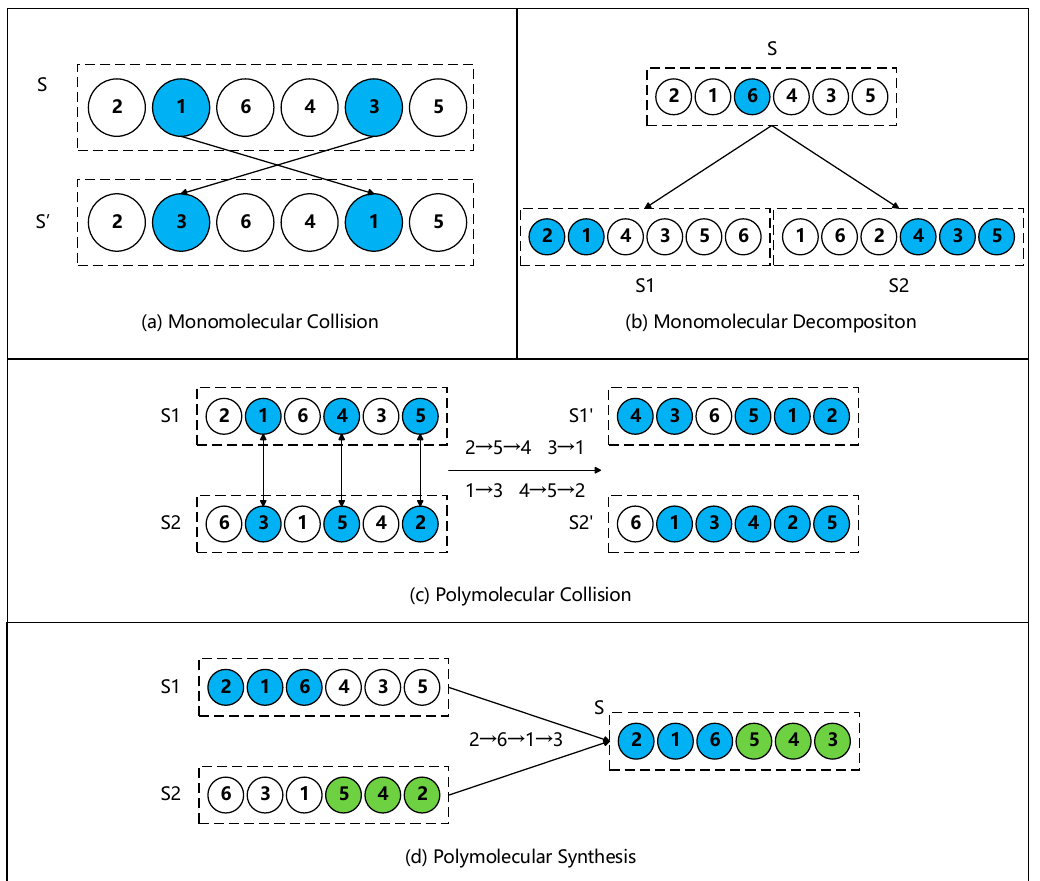
Figure 4. Examples of the updating scheme for the solution space S′. (The blue and green particles in the figure represent the updated part of the solution space, respectively)